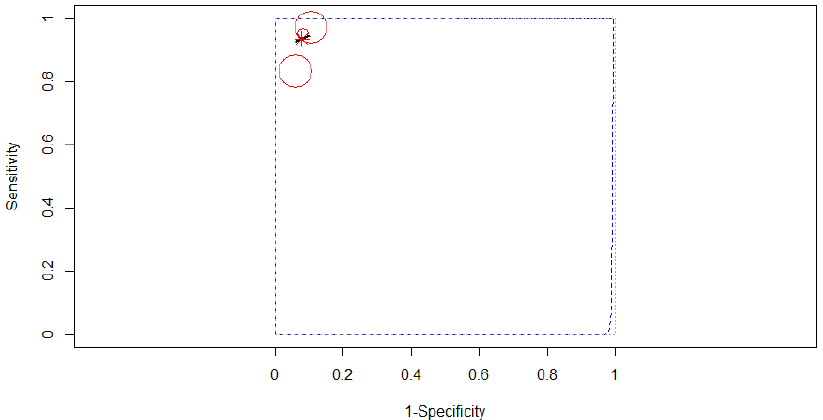
Figure 7. The SROC curve for ANN.